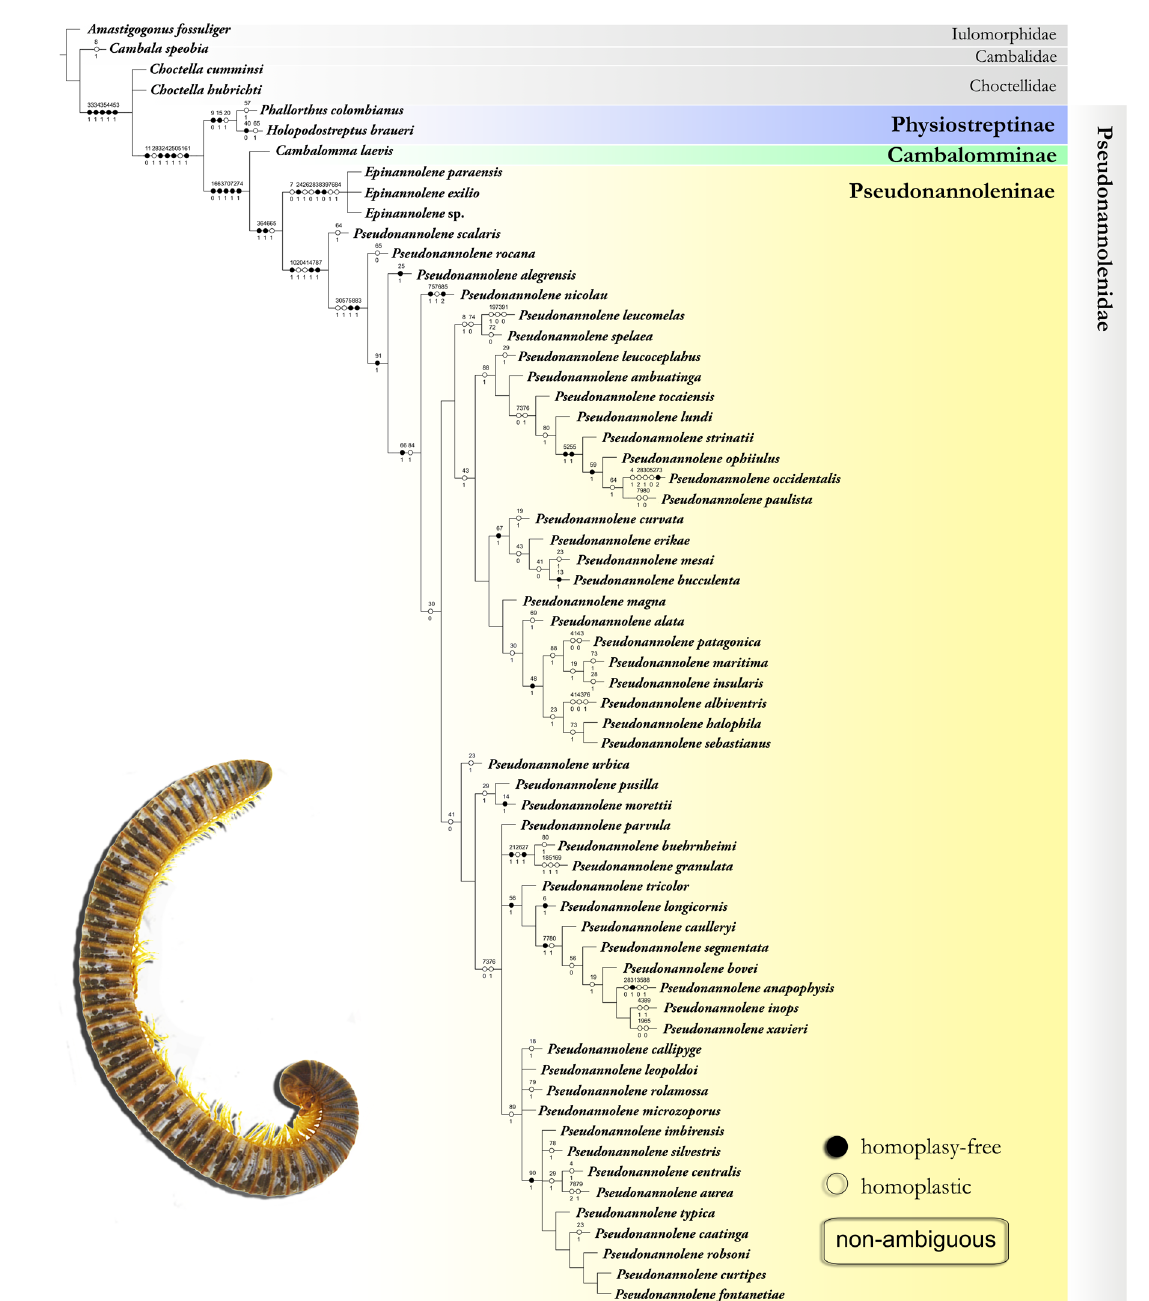
Fig. 8. Strict consensus with optimization of the synapomorphies recovered in all resulting topologies under implied weighting ( k = 4–7). Only discrete characters are